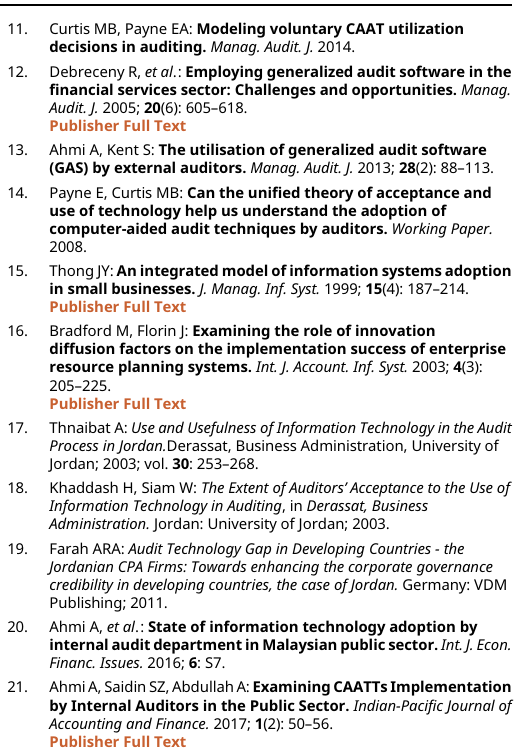
Figshare: List of questions and descriptions of questionnaire of the Modelling Computer Assisted Audit Techniques (CAATs) in Enhancing Indonesian Public Sector, https://doi.org/10.6084/m9.figshare.19642437.v1. 59 This project contains the following extended data: